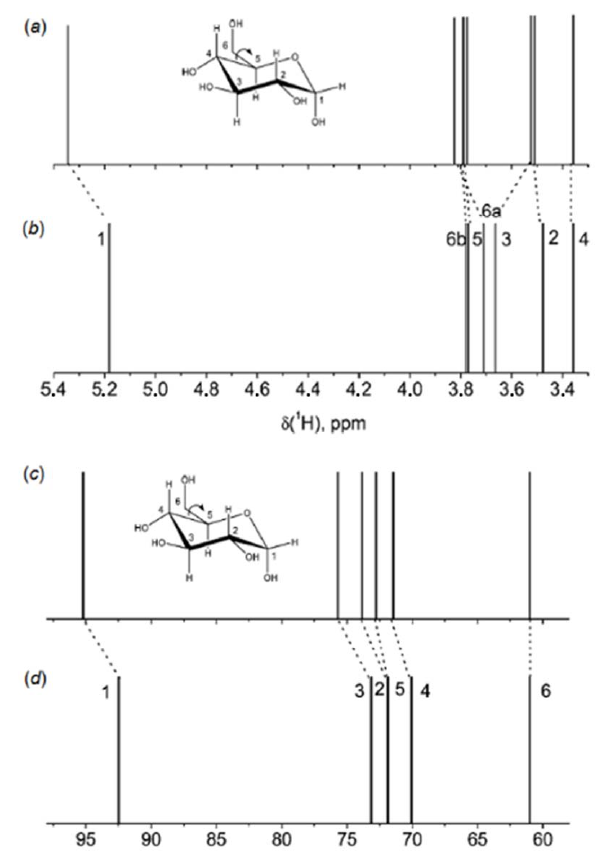
Figure 13. 1 H and 13 C-NMR stick spectra of α -D-glucose in water: ( a , c )—calculated; ( b , d )—experimental. Calculated spectra were shifted to match the most shielded signals. Reproduced with minor editing privilege from Bagno et al. [114] with the permission of the American Chemical